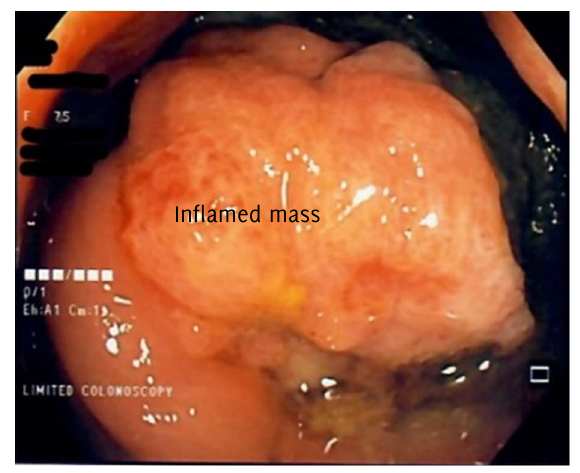
Figure 2 . Colonoscopy of Inflamed Mass in Rectovaginal Fistula.